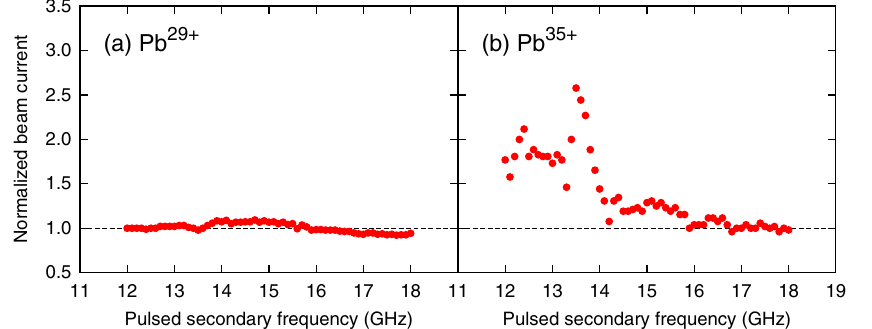
FIG. 9. Pb 29 þ and Pb 35 þ afterglow beam currents as a function of the secondary frequency operated in pulsed mode normalized to the single frequency beam currents ( 192 μ A for Pb 29 þ and 26 μ A for Pb 35 þ ). The main frequency of 14.5 GHz is pulsed with 1920 W and the secondary frequency is operated at a constant 200 W power.